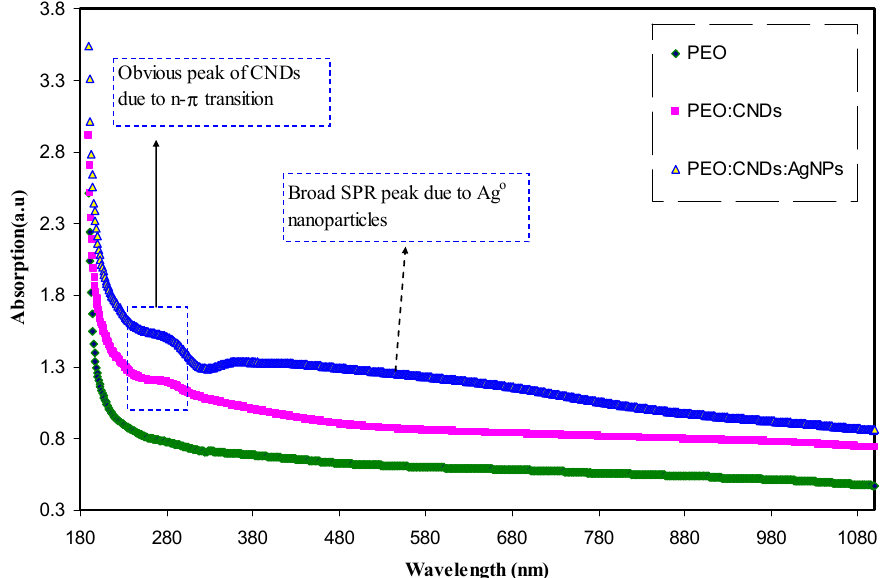
The UV–Vis absorption spectra of the pure PEO, PEO:CNDs, and PEO:CNDs:Ag Figure 3. The UV – Vis absorption spectra of the pure PEO, PEO:CNDs, and PEO:CNDs:Ag composite composite samples.